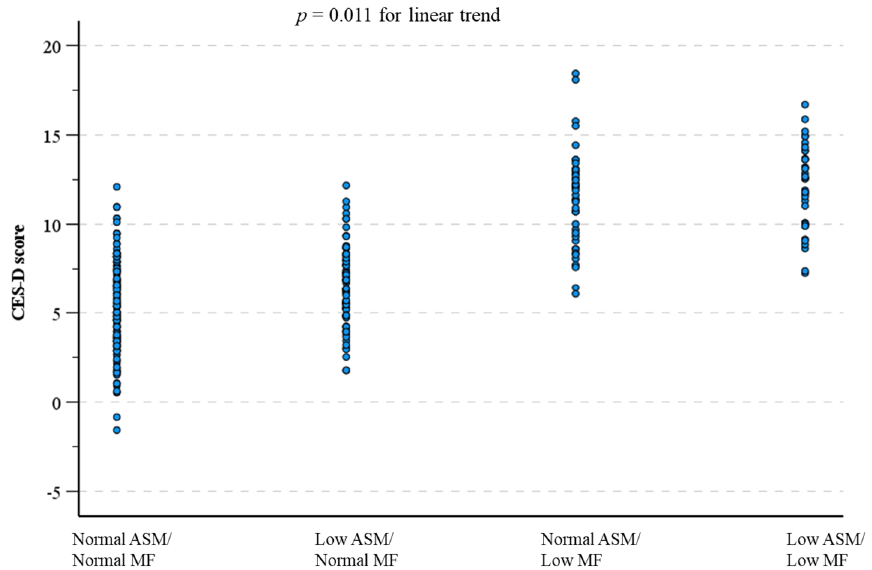
Figure 3. Depressive symptoms stratified by low appendicular muscle mass (ASM)- and low muscle function (MF)-based subgroups. CES-D: the 20-item Center for Epidemiologic Studies Depression Scale.